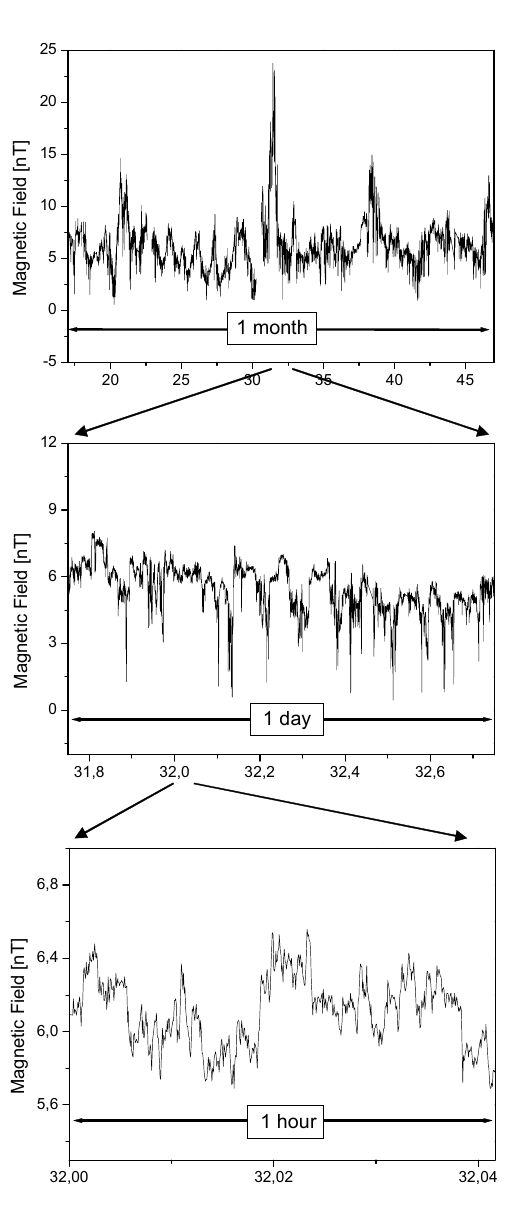
Figure 11: Magnetic intensity fluctuations as observed by Helios 2 in the inner solar wind at 0.9 AU, for different blow-ups. Some self-similarity is evident